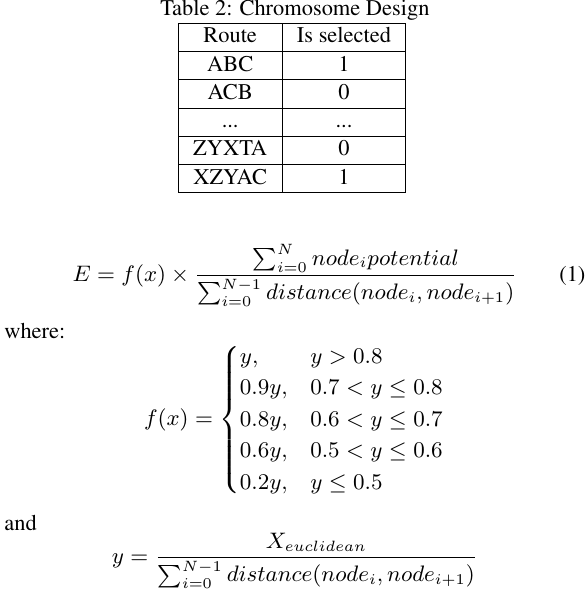
Table 2: Chromosome Design